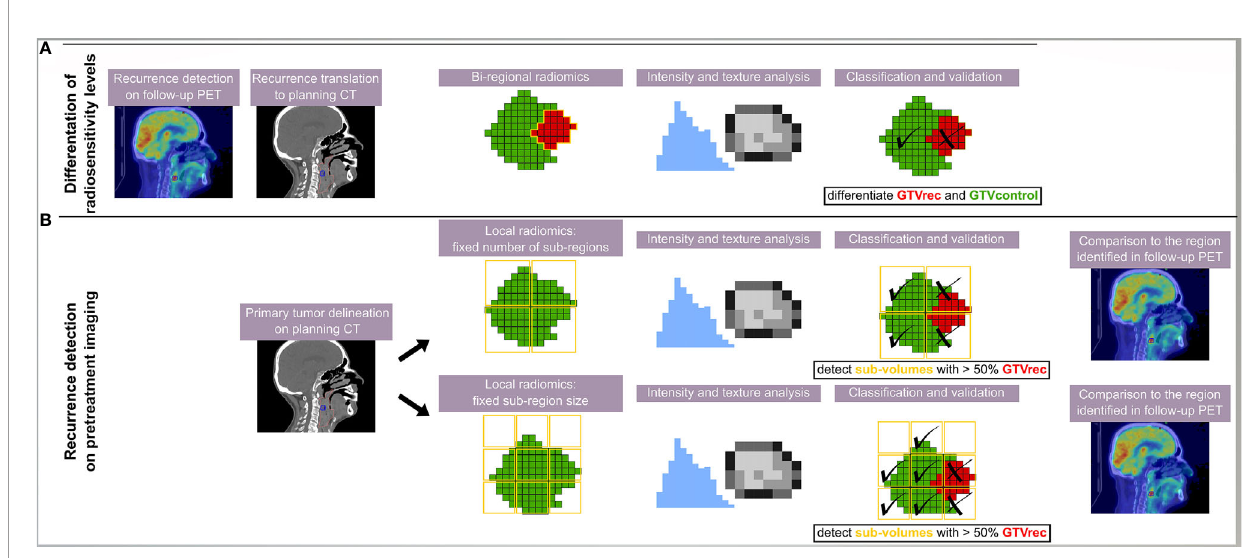
FIGURE 1 | Scheme of the analysis giving an overview on all three radiomics models. The recurrence region was identi fi ed on PET/CT imaging and rigidly transferred to the contrast-enhanced planning CT. Different models were trained using different methods and aiming at different purposes. (A) In the bi-regional radiomics, features were extracted from GTV rec and GTV control and only a differentiation between recurrent and controlled sub-volumes was performed; (B) in two local radiomics models, a detection task was performed and thus sub-volumes were de fi ned without any prior information on the location of recurrence. In the classi fi cation task, a sub-volume was classi fi ed as recurrence (X) if more than 50% of the voxels belonged to the original contour of the recurrence